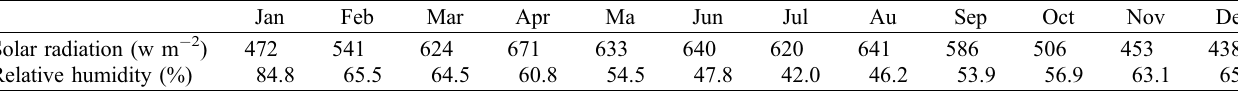
Table 1. Average meteorological parameters of Tizi-Ouzou site, 2011.